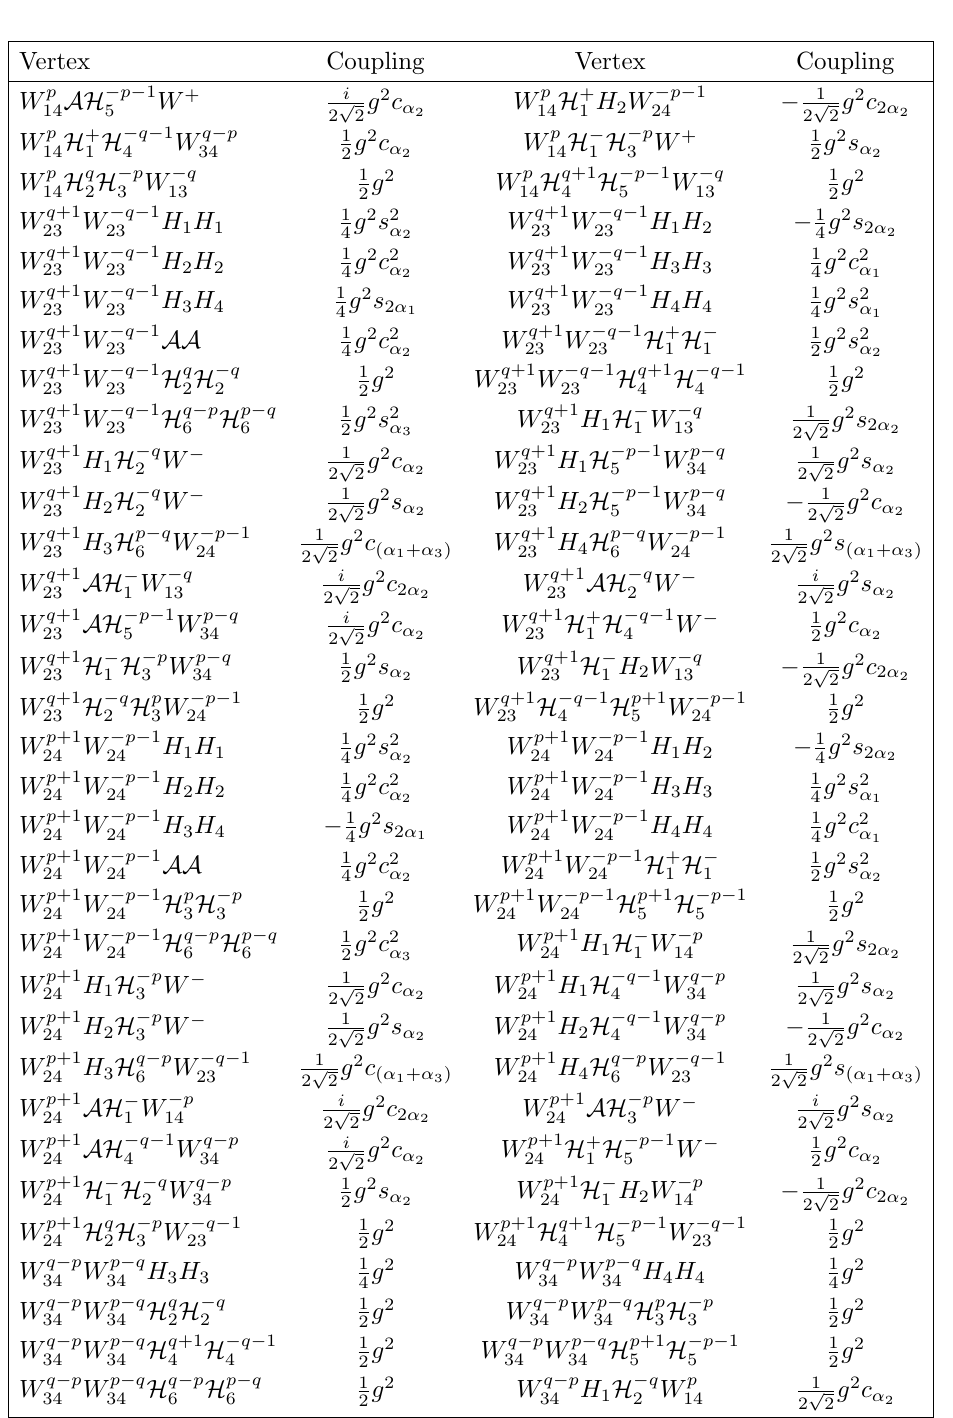
Table 13 . The interactions of two charged gauge bosons with two scalars (Continued).